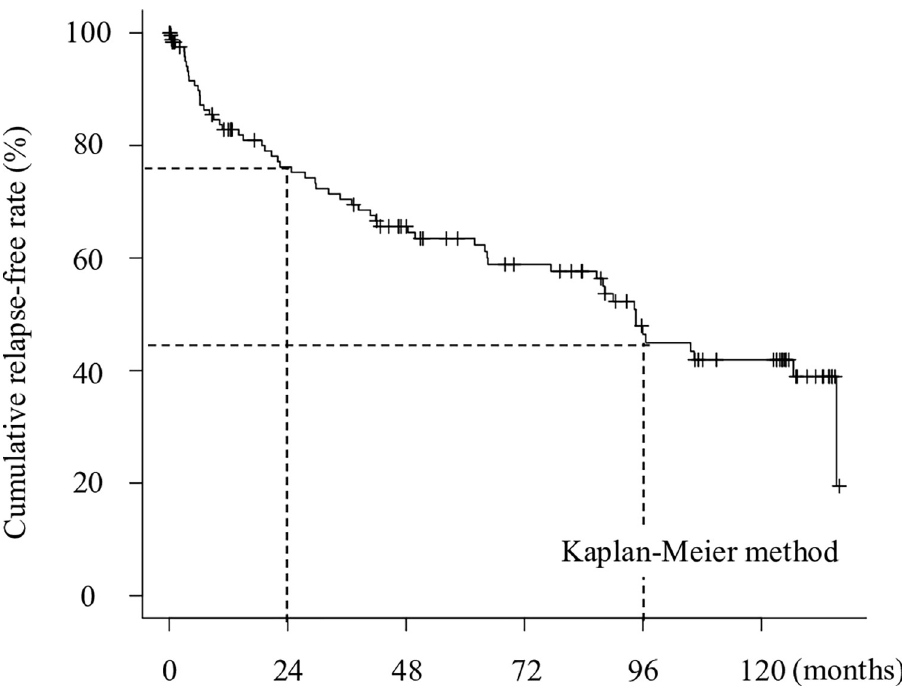
Fig 1. Cumulative incidence of clinical relapse. The cumulative relapse-free rate was 76.2% and 46.4% at 24 and 96 months, respectively.